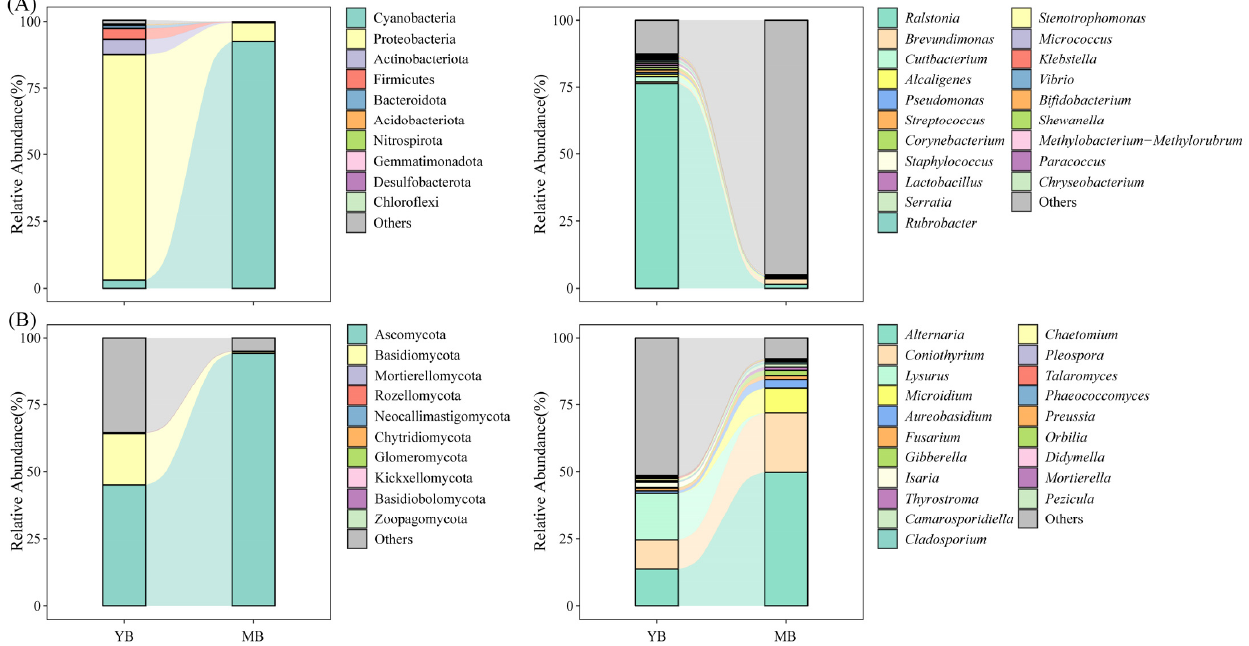
Figure 4. Microbial composition at the phylum and genus level of endophytic bacteria ( A ) and fungi ( B ) in young and mature branches of Nitraria tangutorum . YB: young branches; MB: mature branches.